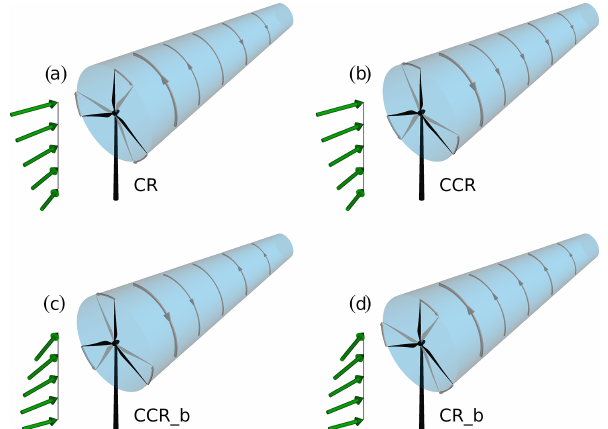
Figure 8. Schematic illustration of the rotational direction of the wake for the following cases: clockwise blade rotation CR with veering wind in NH (corresponding to backing wind in SH) in (a) , counterclockwise blade rotation CCR with veering wind in NH in (b) , counterclockwise blade rotation with backing wind CCR_b in NH (corresponding to veering wind in SH) in (c) , and clockwise blade rotation with backing wind CR_b in NH in (d) .